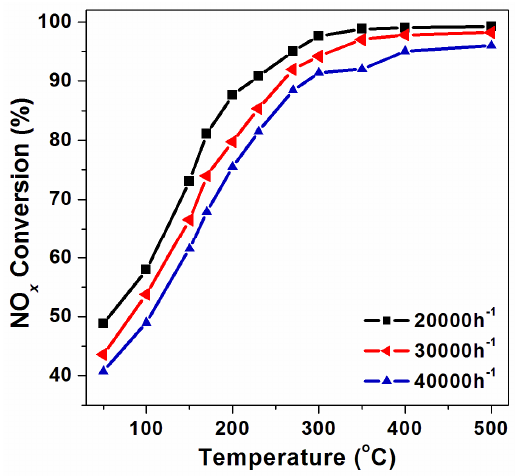
Figure 6. Influence of GHSV variation on NO x conversion over Fe0.5-W-Ce catalyst. Reaction conditions: [NO x ] = 450 ppm, [NH 3 ] = 450 ppm, 2.5% O 2 , N 2 as balance.